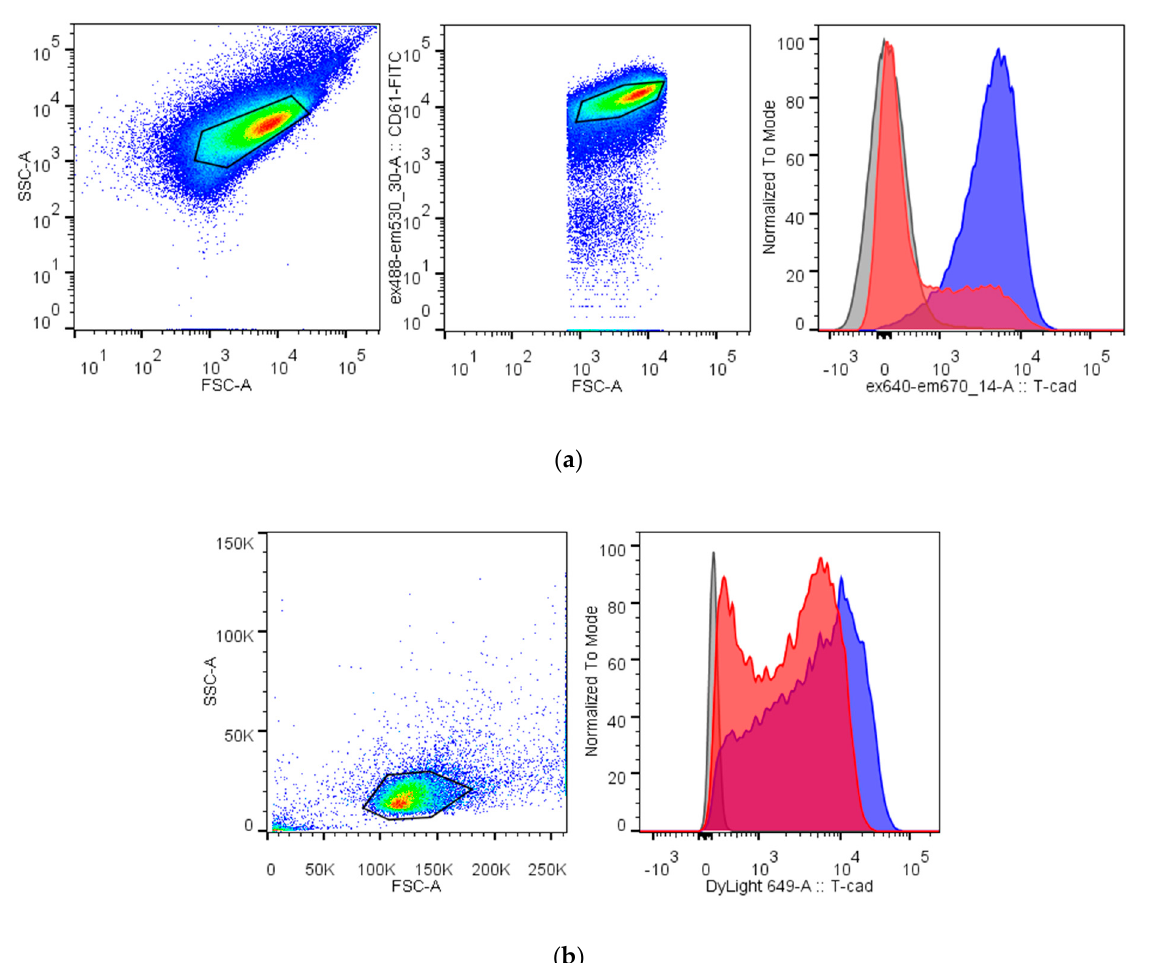
Figure 4. Digestion with phosphatidylinositol-specific phospholipase C (PI-PLC) decreases binding of the specific antibody against T-cadherin to platelets ( a ) and MEG-01 ( b ). Platelets are identified by their FSC/SSC characteristic (the first gate) and positive CD61 labeling (the second gate), MEG-01 cells are identified by the other FSC/SSC gate. Right histograms show fluorescence from the binding of the anti-T-cadherin antibody before (blue) and after (red) PI-PLC treatment and from the isotypic control (gray).